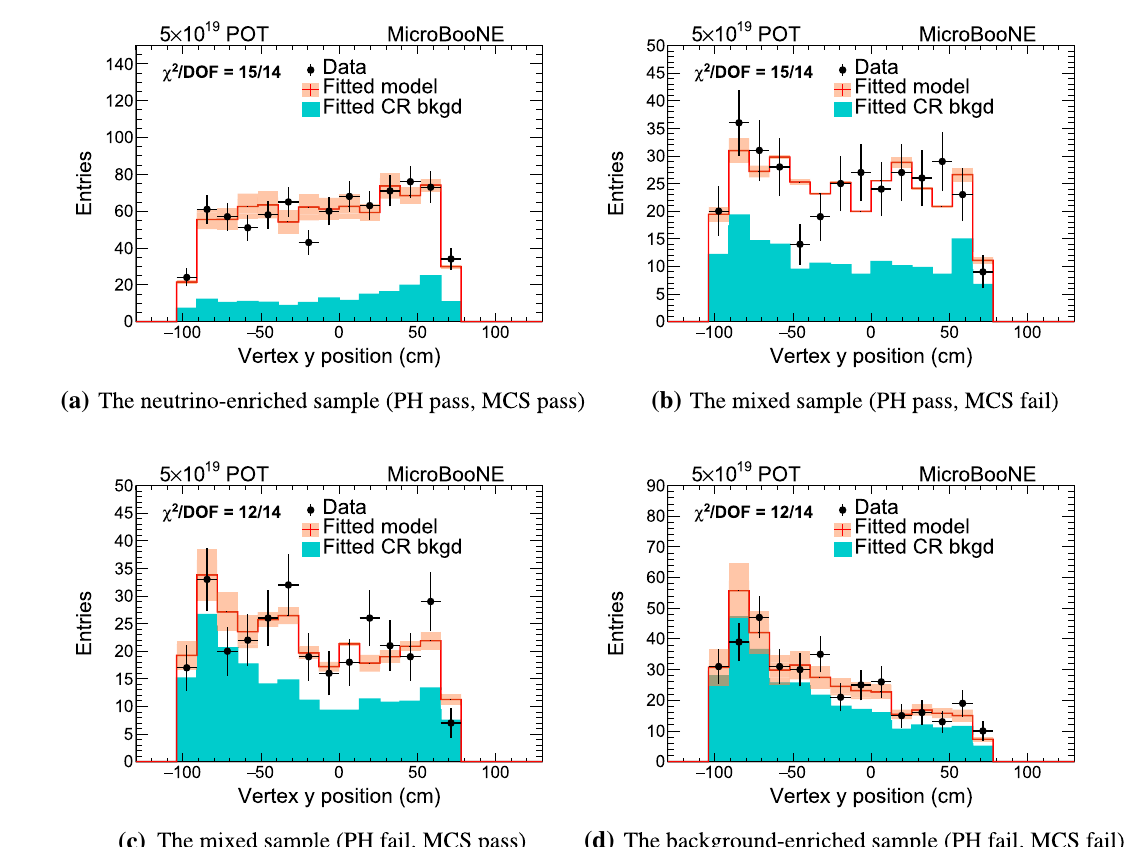
Fig. 12 Neutrino interaction reconstructed vertex position along y -axis for data and GENIE default MC. Neutrino-enriched sample is nearly flat as expected. The asymmetry in the CR-background-enriched category corresponds to “upwards-going cosmics” which is a known feature of the